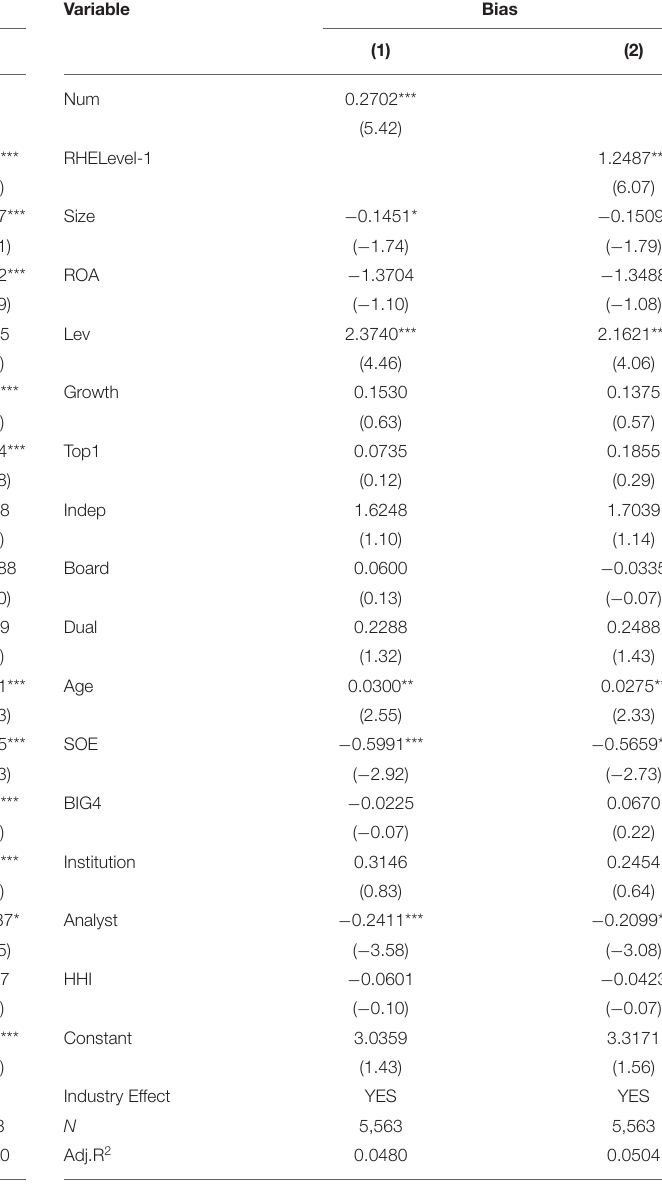
TABLE 12 | COVID-19 impact on earnings manipulation. TABLE 13 | COVID-19 impact on forecast accuracy.